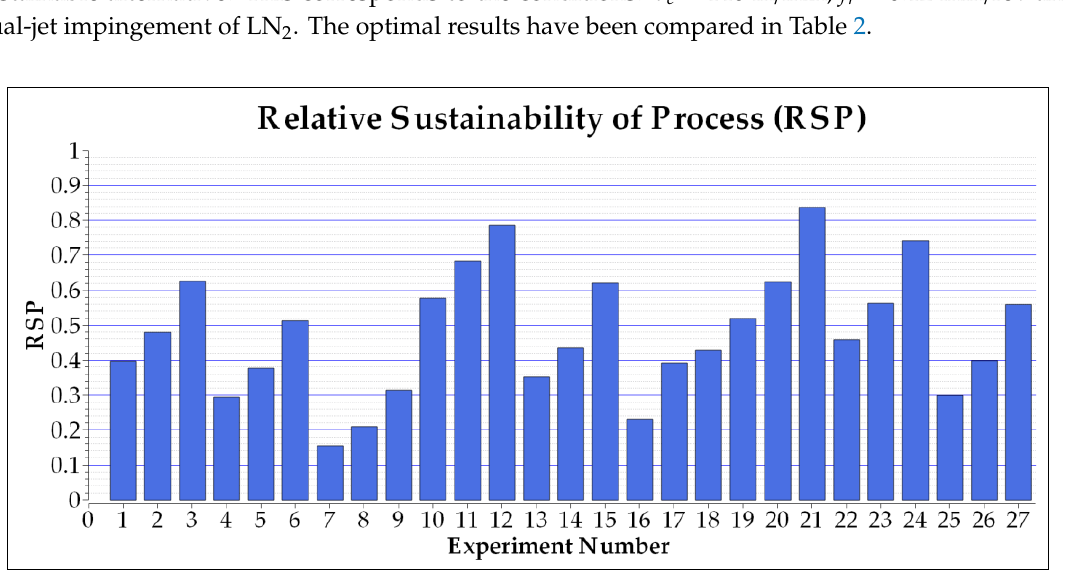
Figure 3. RSP of the alternatives in Mia et al. [23]. Table 2. The machining responses of the best alternative as predicted by the proposed algorithm vs. the optimal results stated in the